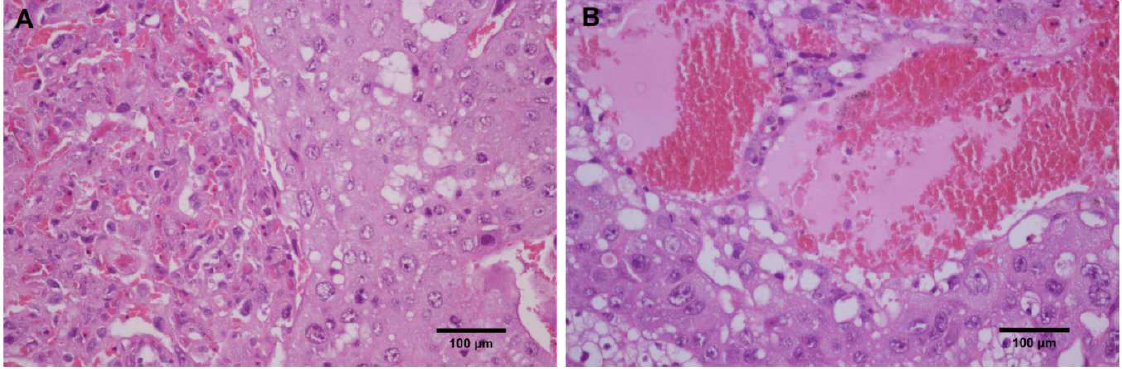
Figure 1. Placental pathology in pregnant rats (magnification, ×200). ( A ) the CK group; ( B ) the CP